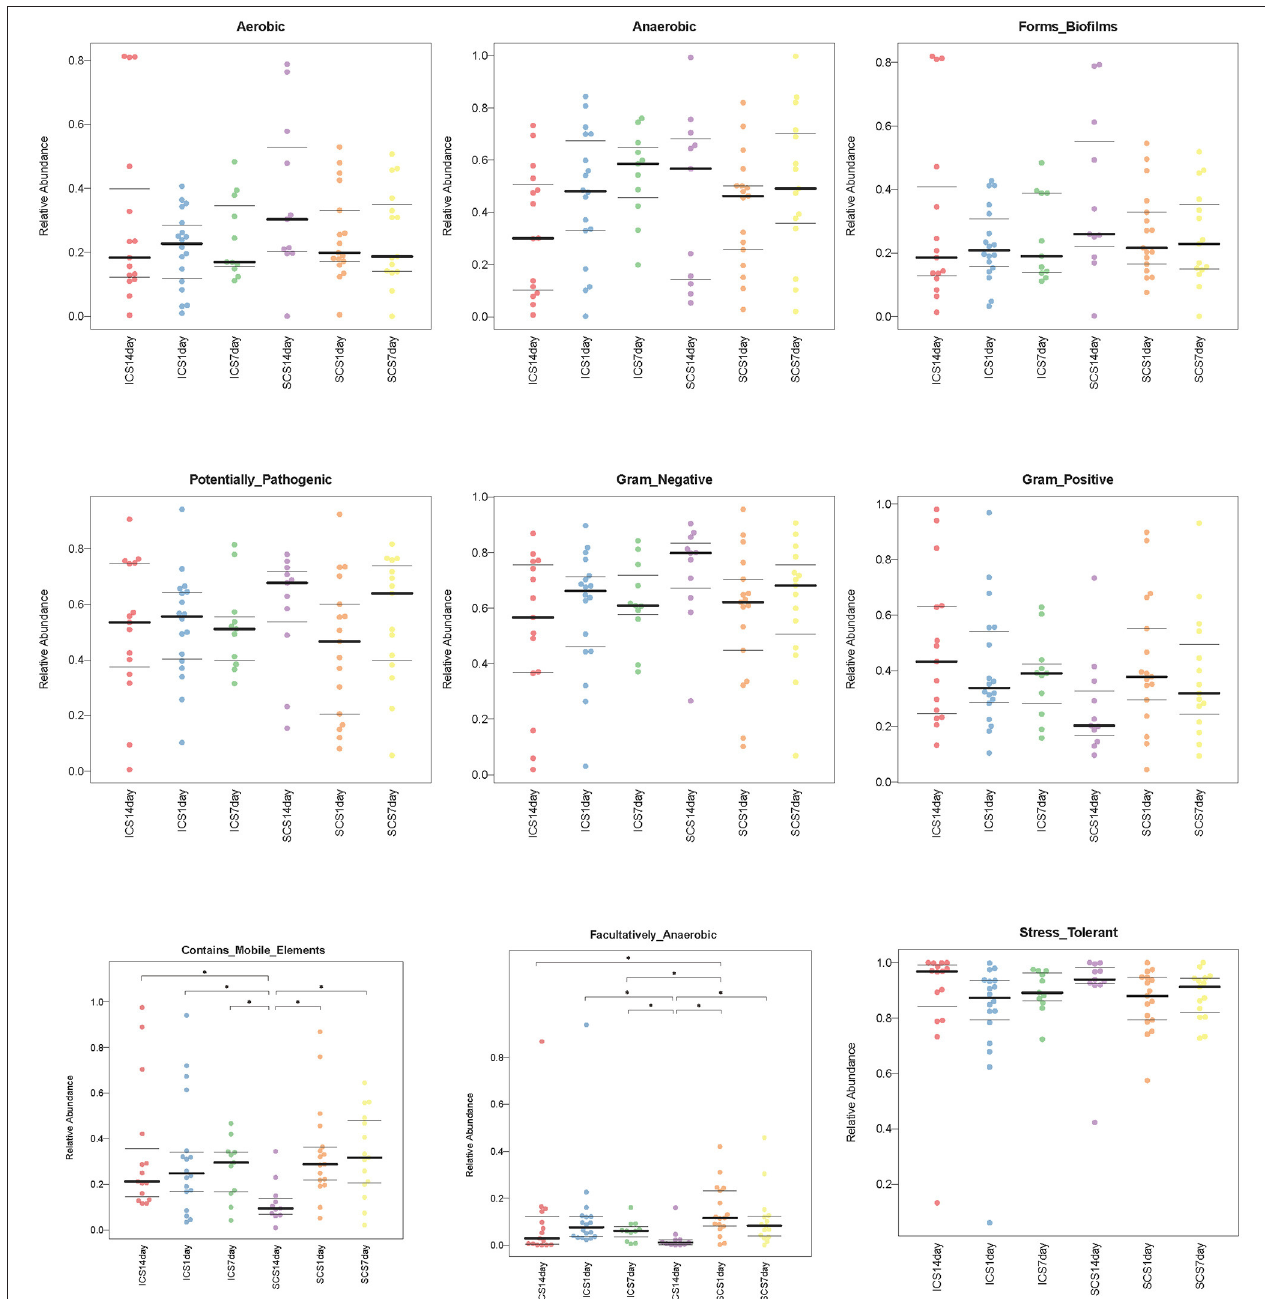
FIGURE 12 | Compared the bacterial composition predicted by BugBase in two groups. Significant differences can be found in facultatively anaerobic content and mobile elements ( p < 0.05). After treatment for 14 days, the levels of mobile element genes were decreased in the SCS group compared with the ICS group. ICS and SCS have the same effect on aerobes, anaerobes, potentially pathogenic bacteria, bacteria related to biofilm formation, gram-negative bacteria, gram-positive bacteria, facultative anaerobes, and oxidative stress-tolerant bacteria. The data were summarized as the quartile and